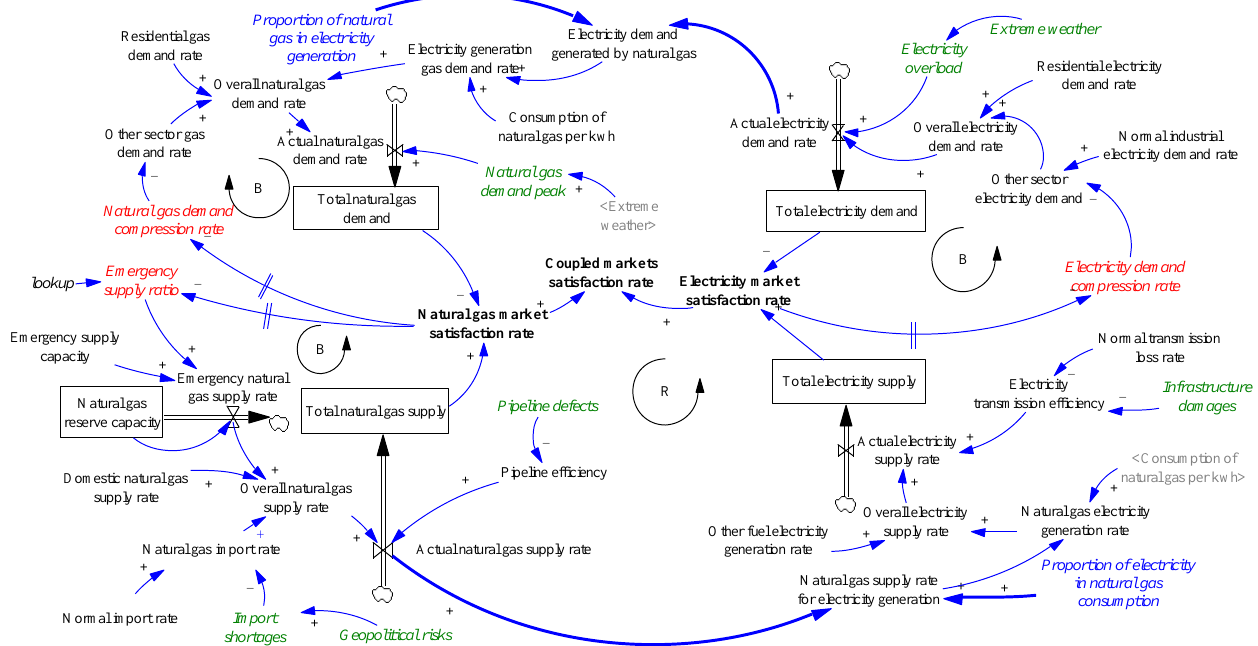
Figure 2. System dynamics model for assessing the risk of the coupled natural gas–electricity market (R: Reinforcing loop, B: Balancing loop).